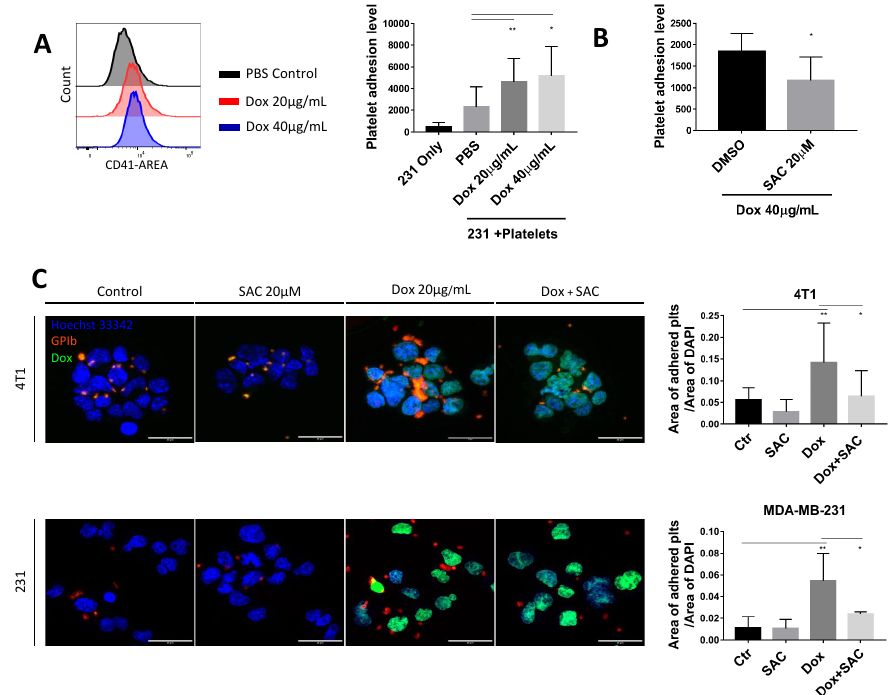
Figure 2. Dox Enhances cancer cell-platelet Interaction. ( A , B ) Platelet adhesion levels to MDA-MB-231 cells stained for platelet marker CD41 and quantified by flow cytometry. ( C ) Confocal imaging of breast cancer cell lines (4T1, upper row and MDA-MB-231, lower row) interacting with murine platelets. Cell nuclei were stained with Hoechst 33342 (blue); platelets were stained with GPIb β (red); and Dox exhibited autofluorescence (green). The level of platelet-cancer cell interaction was shown as GPIb β fluorescence area per area of Hoechst. Representative images chosen from 3 separate experiments. Scale bars = 30 µ m. The fluorescence area was quantified using the Area Quantification FL module on HALO ® platform. Data are displayed as mean ± SD. n ≥ 3 for all experiments. Statistical significance was determined by one-way ANOVA ( A , C ) or paired t -test (B). (* p < 0.05, ** p < 0.01). Ctr = Control, 231 =